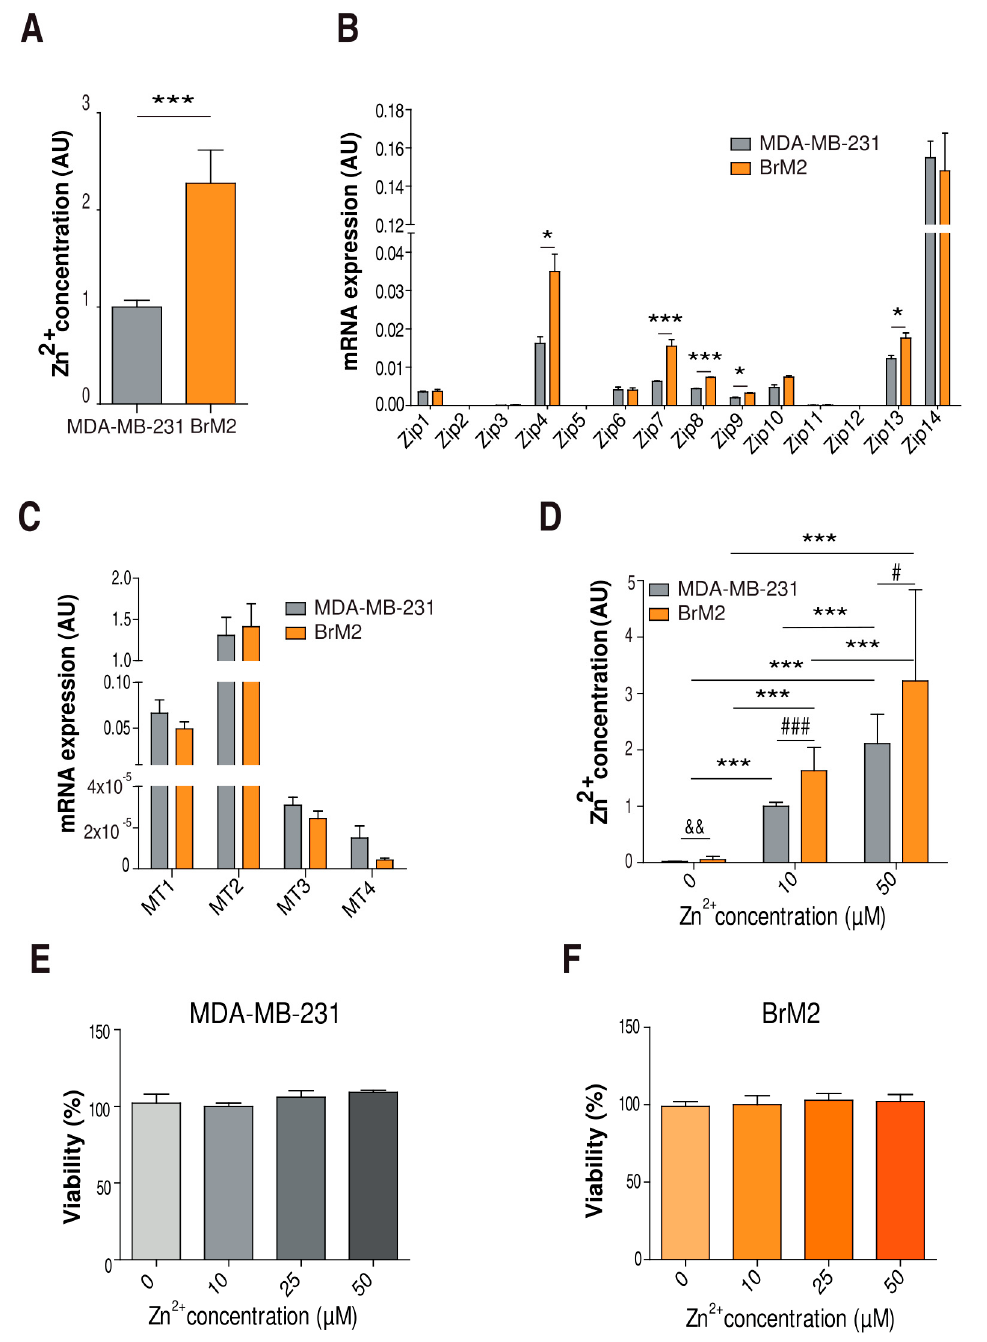
Figure 1. Characterization of zinc homeostasis of MDA-MB-231 and BrM2 cells. ( A ) Evaluation of zinc content by flow cytometry using Zinquin in basal conditions ( n = 12); *** p < 0.005 using Mann–Whitney test. ( B , C ) Real-time PCR comparing expression of Zip transporter family ( n = 3) and metallothioneins ( n = 6–9) in MDA-MB-231 and BrM2 cells in basal conditions. 2-DCT plotted using GAPDH as a housekeeping gene; * p < 0.05, *** p < 0.005 using t -test. ( D ) Evaluation of zinc content by flow cytometry using Zinquin after 24 h of treatment with 0, 10, and 50 µM of ZnSO 4 (n = 6–9); *** p < 0.005 using ANOVA and Tukey’s multiple comparison test; && p < 0.01 using Mann–Whitney test; # p < 0.05, ### p < 0.005 using t -test. ( E , F ) Evaluation of cell viability by MTT in MDA-MB-231 and BrM2 cells grown at different zinc concentrations for 48 h (n = 3).